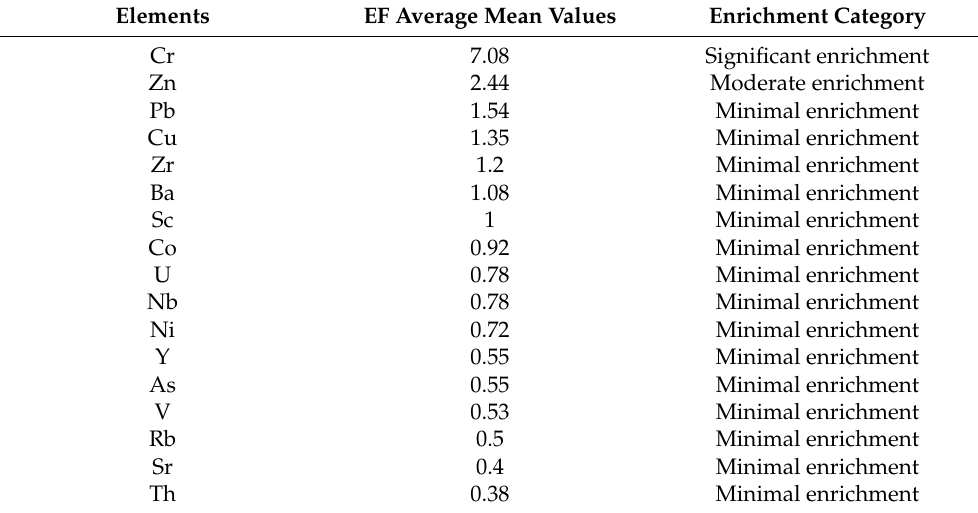
Table 8. Enrichment factor (EF) values of trace elements in road dust.